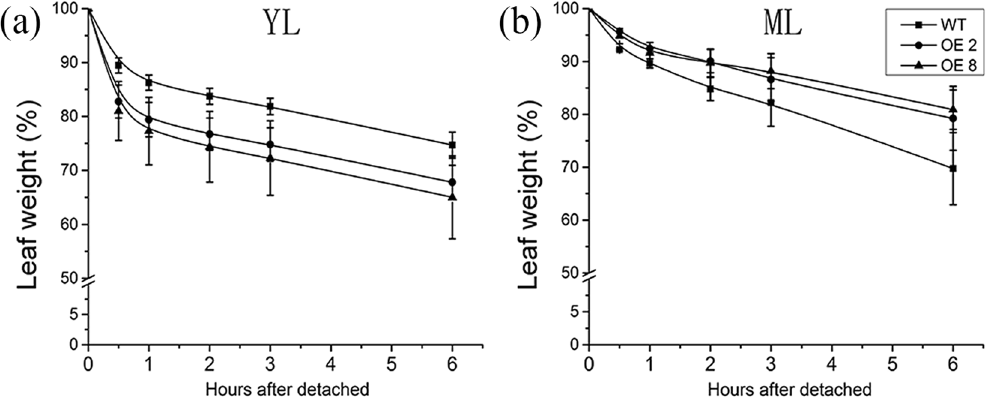
Figure 4. Rate of water loss from wild type and 35 S:PRE2 lines detached leaves at 25 °C room temperature. ( a ) and ( b ) represent rate of water loss in young leaves (YL) and mature leaves (ML), respectively. Data are the mean ± SD of three biological